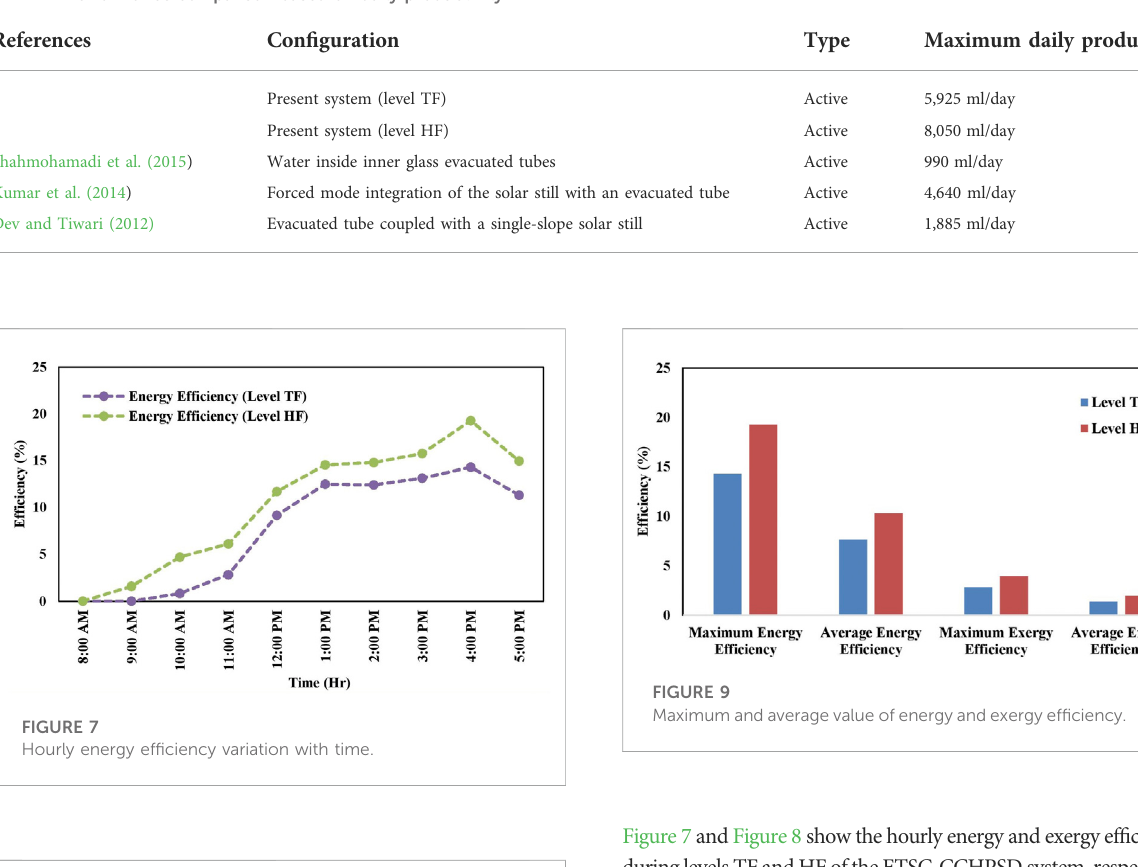
TABLE 4 Performance comparison based on daily productivity.